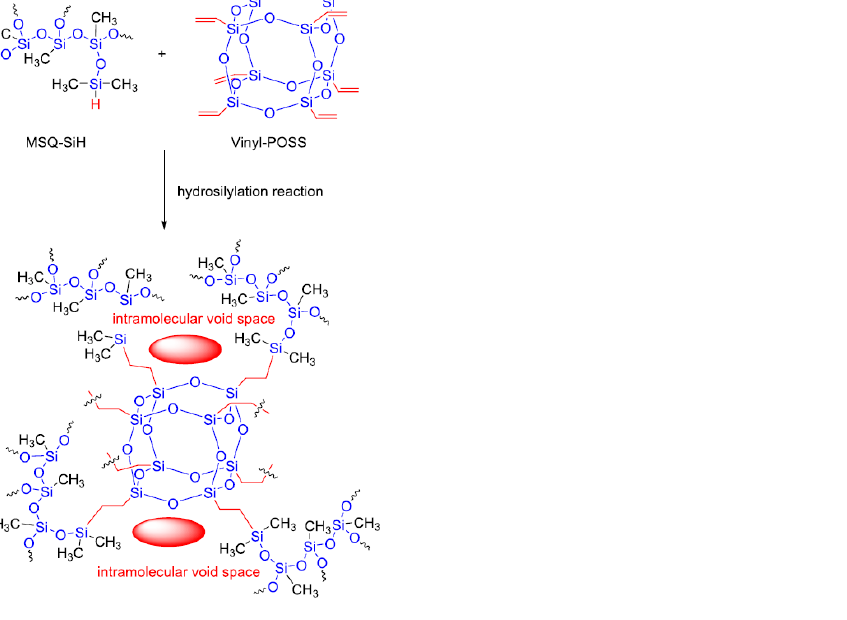
Figure 16. The hydrosilylation of hydrodimethyl-silylated oligomethylsilsesquioxane (MSQ-SiH) and octavinyl polyhedral oligomeric silsesquioxane (Vinyl-POSS). Reproduced with permission from Ref. [55]. Copyright 2021 American Chemical Society.